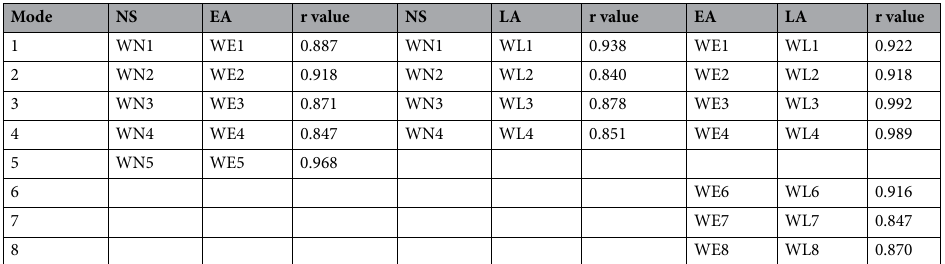
Table 2. Similarity between the structure of muscle synergies across the novel slips (NS), early-adapted slips (EA), and late-adapted slips (LA). The pairs with similarity > 0.834 (corresponding to p < 0.01) were classified into same mode, and total 8 modes were detected in this